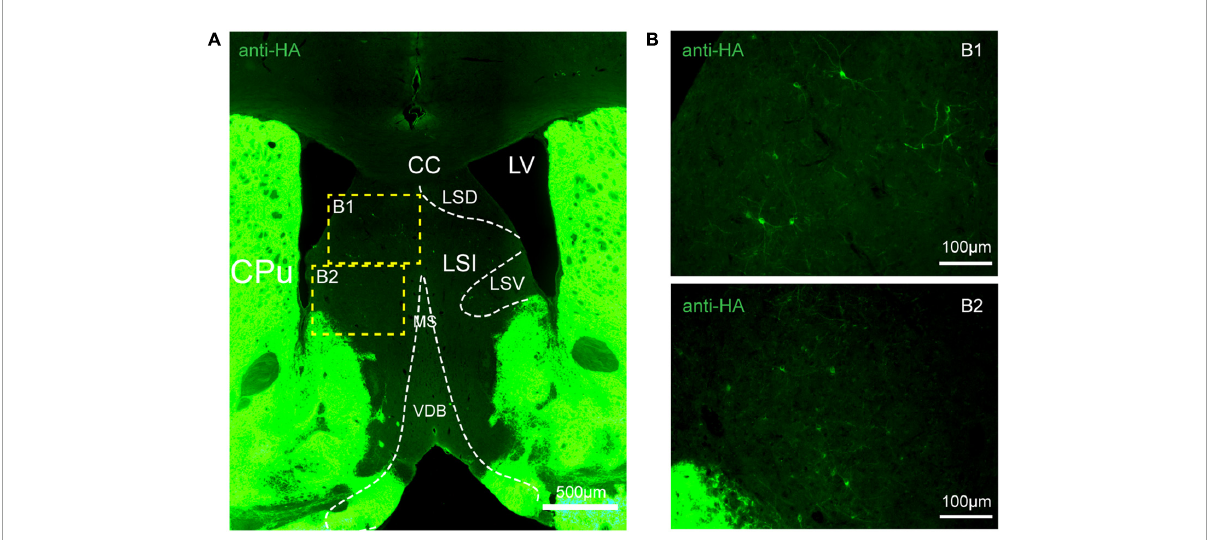
FIGURE5 Distribution of HA immunoreactivity in the lateral septum of adenosine A 2 A receptor (A 2A R)-tag mice. (A) Representative confocal image of HA expression in the septum structure (0.86 mm before bregma). Bright labeled cells were observed in the LS and no staining was detected in the medial septum or the horizontal and vertical limbs of the diagonal band. (B) High magnification of the areas (B1,B2) in yellow indicated in panel (A) . CPu, caudate putamen (striatum); LV, lateral ventricle; CC, central canal; LSD, lateral septal nucleus, dorsal part; LSI, lateral septal nucleus, intermediate part; LSV, lateral septal nucleus, ventral part; MS, medial septal nucleus; VDB, nucleus of the vertical limb of the diagonal band. Scale bars as indicated in each